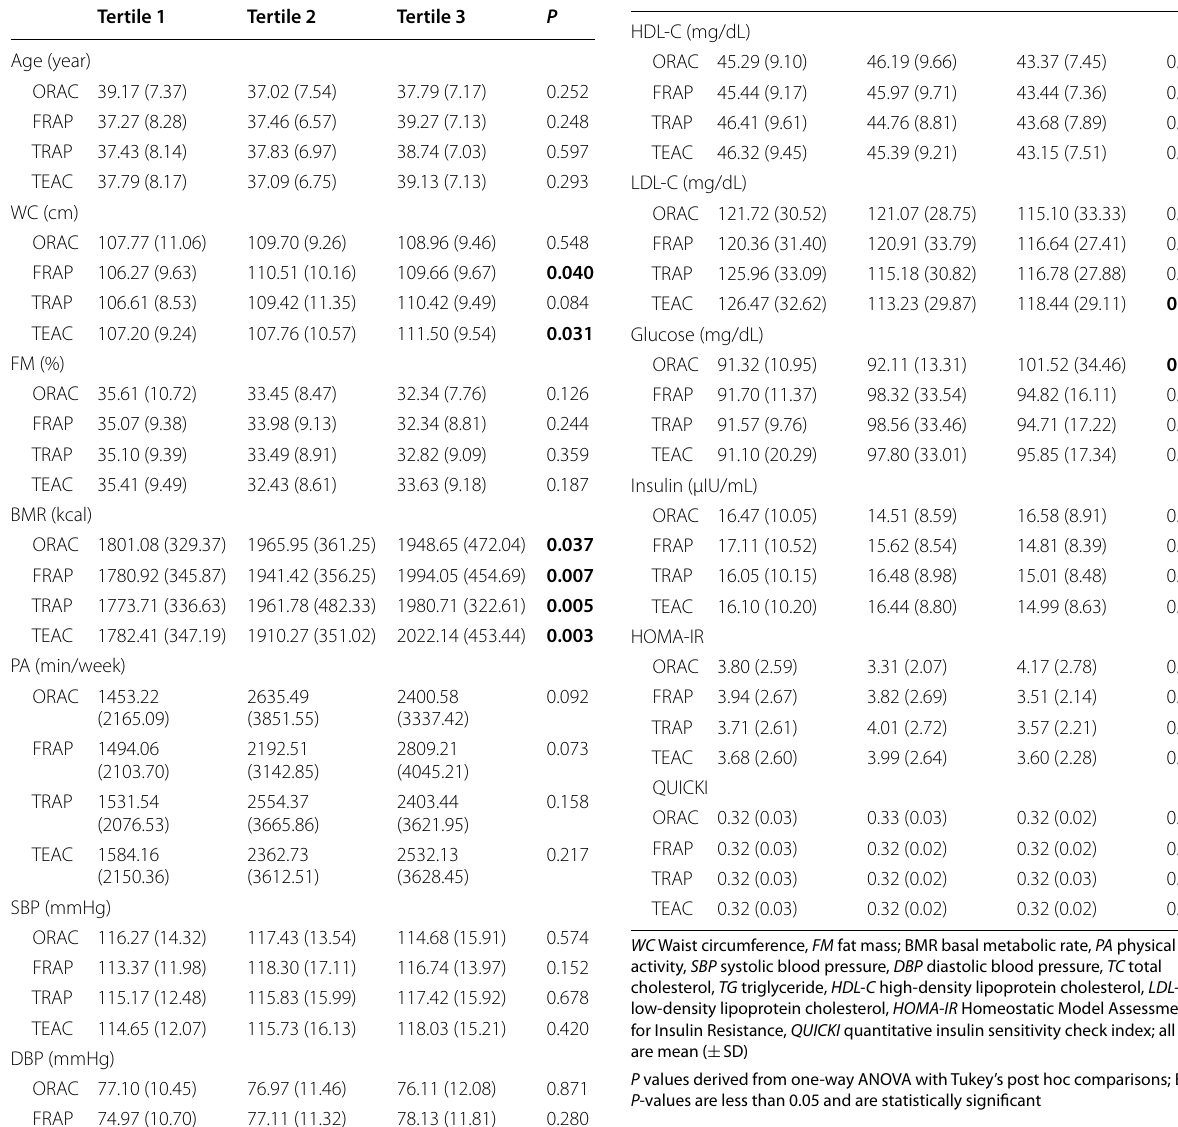
Table 5 General characteristics and metabolic factors of study population by dietary NEAC